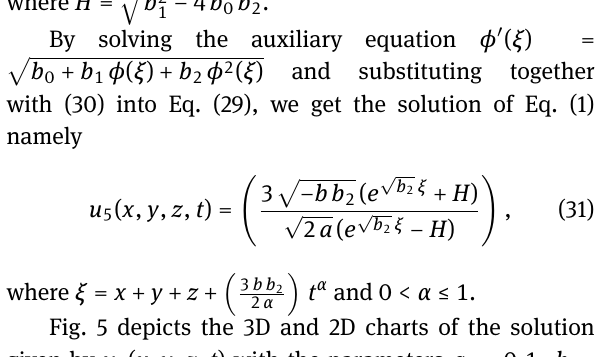
(cid:113) b 2 1 − 4 b 0 b 2